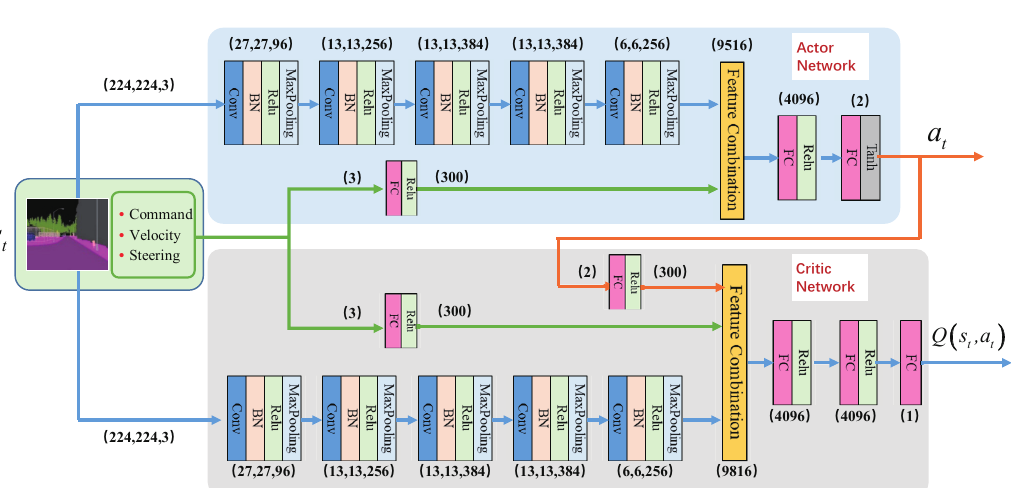
Figure 5. The actor–critic network structure in PORF-DDPG. For the input state s t , the image whose size is (224,224,3) is fed into a 5-layer CNN to generate a feature map whose size is (6,6,256), and the 3-dimensional vector <command, speed, steering> is expanded to a 300-dimensional vector through a fully connected neural network. For the actor network, the expanded vector is combined with the feature map to generate the action a t = < steering control , speed control > through a fully connected neural network. The critic network has one more input action a t than the actor network. Similar to the actor network, the features extracted from the input state s t and the action a t are combined and fed into the fully connected neural network to obtain Q ( s t , a t )